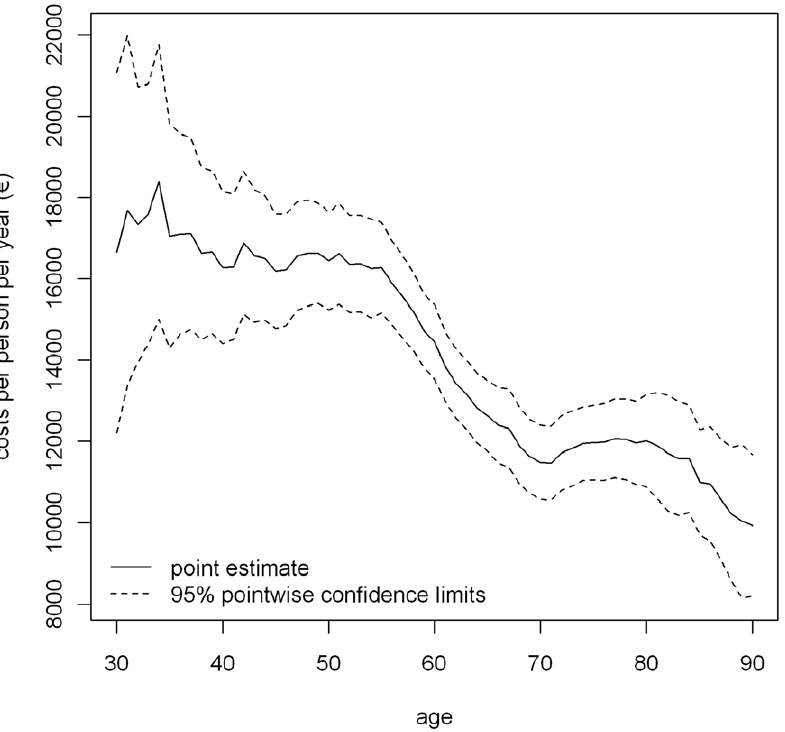
Figure 1. The absolute health expenditures of women with breast cancer (costs in 2010 euros).